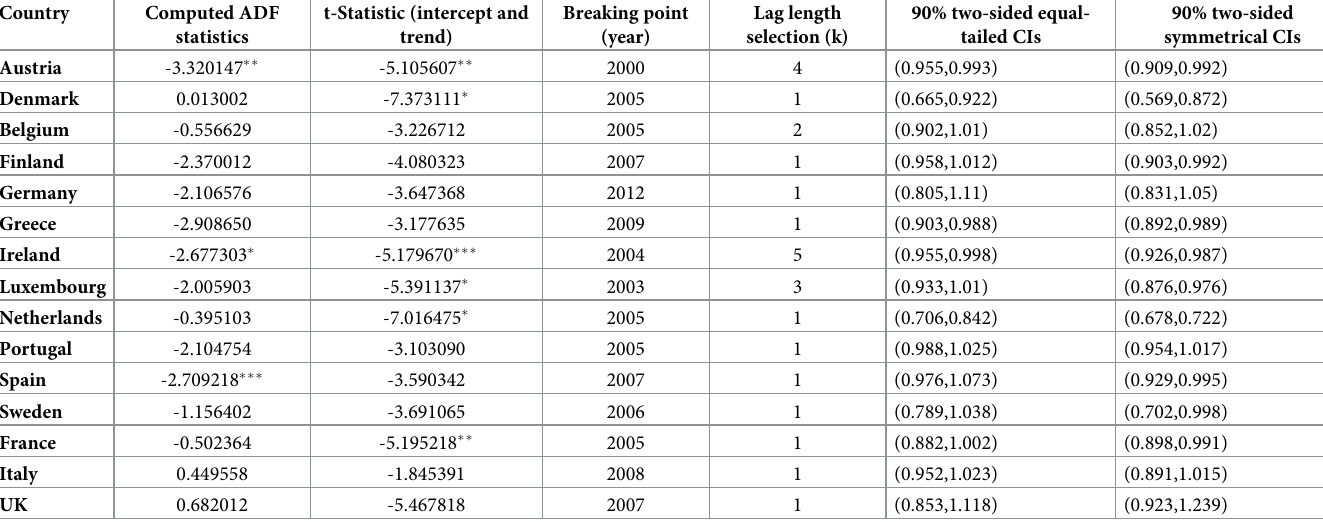
Table 7. Results of ADF and Zivot-Andrews tests and subsampling confidence intervals for EU-15 countries (1990–2018).